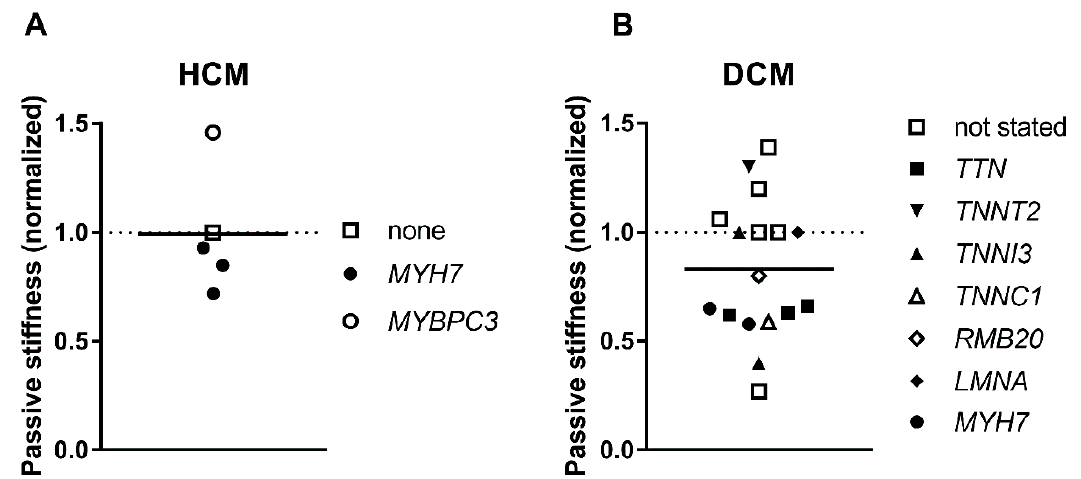
Figure 6. Passive stiffness. Passive stiffness was evaluated as a Young’s modulus or as a passive tension generated by muscle at stretch. Each data point represents a different experimental group where the symbols indicate genes where mutations were found. The values for HCM ( A ) and DCM ( B ) are normalized to control donor hearts (dashed line). The data is from Tables 1 and 2.